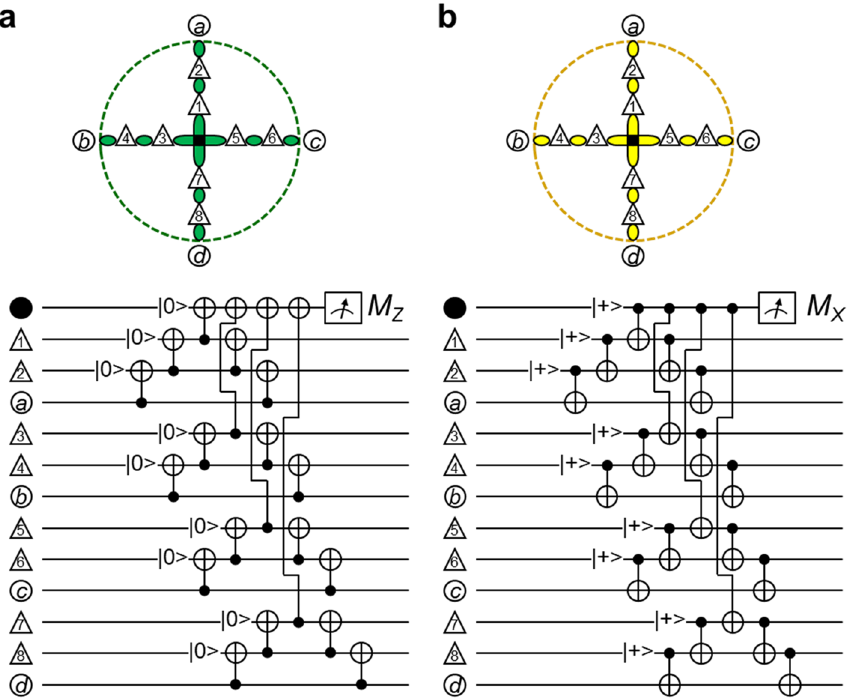
Figure 5. Circuits for a simple method of stabilizer measurements. CNOTs are repeated to transfer the information on data qubits to a syndrome qubit. ( a ) Circuit for detecting a bit-flip error. ( b ) Circuit for detecting a phase-flip error.